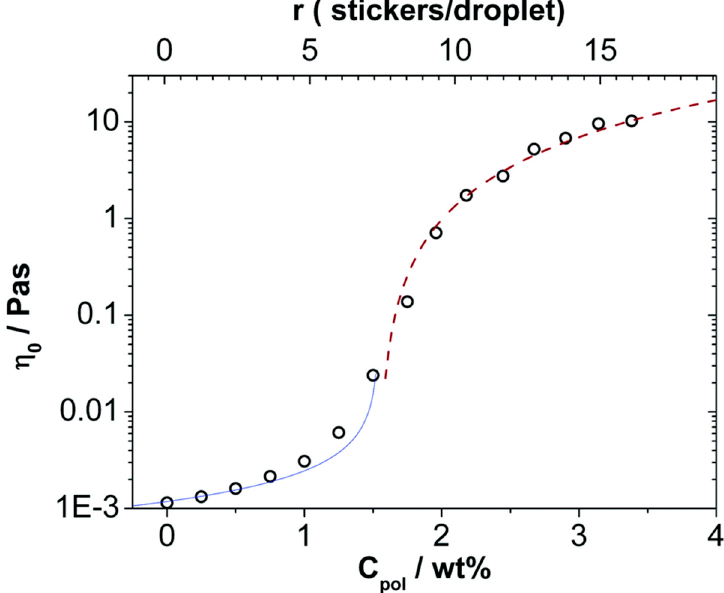
Figure 10. Zero-shear viscosity η 0 at 25 °C of the mixtures of a microemulsion (100 mM TDMAO/35 mM decane in water) as a function of the concentration of C 18 -EO 150 -C 18 measured with a capillary viscometer until a concentration of 2 wt % and with the instrument AR-G2 above this concentration. Solid line: η 0 = 0.0016((1.54 − c)/wt %) − 0.7 . Dashed line: η 0 = 3.6((c − 1.54)/wt %) 1.7 ([136]—Published by The Royal Society of Chemistry).